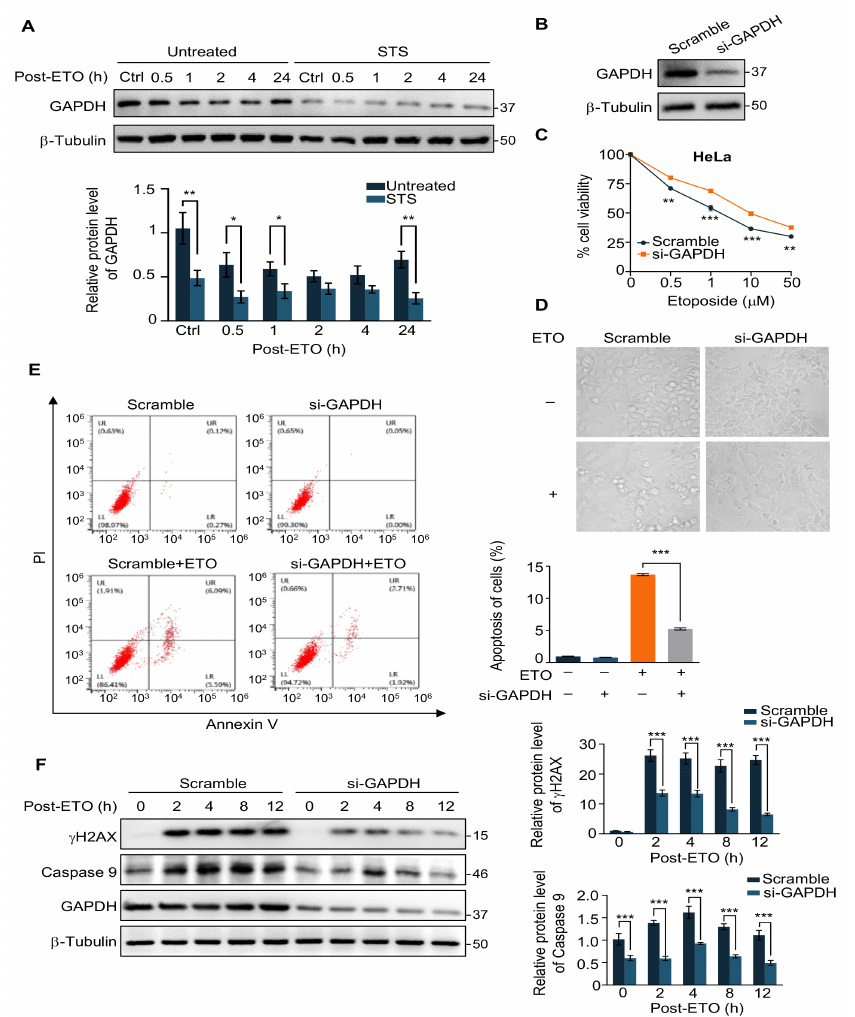
Figure 2. Knockdown of GAPDH mimics the protective effect of STS in response to ETO. ( A ) Immunoblot ( upper ) and quantification ( lower ) of GAPDH in HeLa cells pre-starved or un- treated for 24 h with 20 µ M ETO treatment for 2 h following different recovery times. ( B ) Immunoblot of GAPDH in HeLa cells transfected with scramble siRNA and si-GAPDH for 48 h. ( C ) Cell viability of HeLa cells transfected with scramble siRNA and si-GAPDH for 24 h was treated with the indicated concentration of ETO for 24 h. ( D ) Morphological analysis of control or GAPDH knockdown HeLa cells with or without ETO treatments (20 µ M, 2 h). ( E ) Annexin V/PI staining and flow cytometry assay ( left ) and quantification ( right ) of control or GAPDH knockdown HeLa cells with or without ETO treatments (20 µ M, 2 h). ( F ) Immunoblot ( left ) and quantification ( right ) of indicated proteins in control or GAPDH knockdown HeLa cells with 20 µ M ETO treatment for different recovery times. Data represented as mean ± SD of at least three independent experiments. p values are from